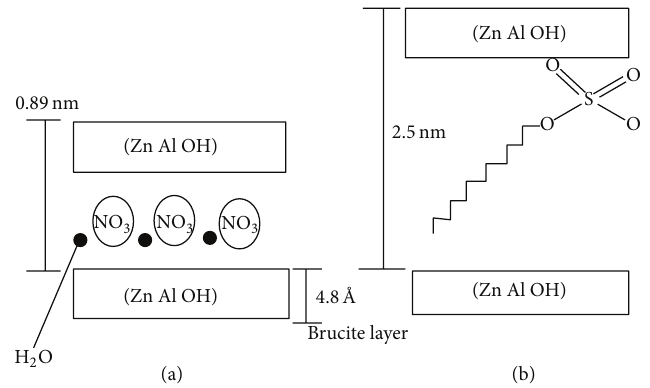
Figure 1: Schematic figure of (a) LDH and (b)